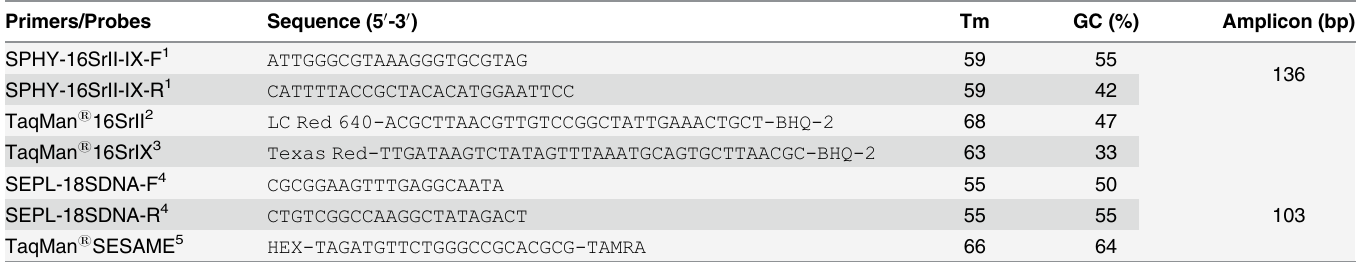
Table 2. Primers and TaqMan 1 probes designed for multiplex qPCR detection of 16SrII and 16IX phytoplasmas and sesame DNA.